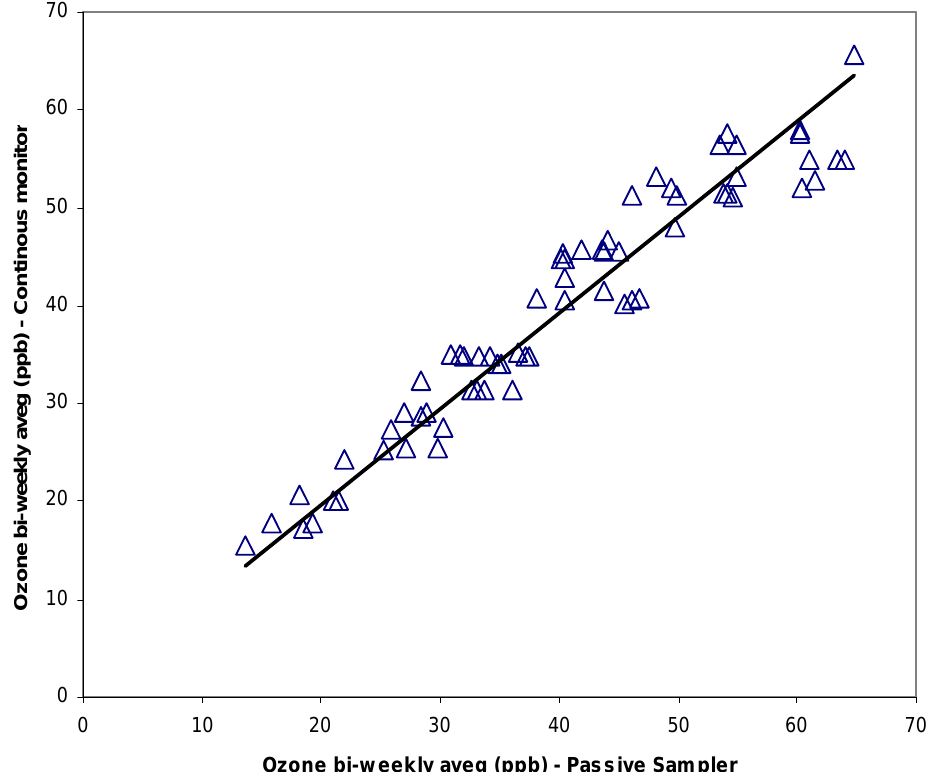
FIGURE 1 . Ozone measured by passive samplers vs. measured with active monitors (Dasibi Model 1008 RS) throughout the study for all sampling periods. The regression equation: y = 0.901x + 3.51 r 2 = 0.911 (being